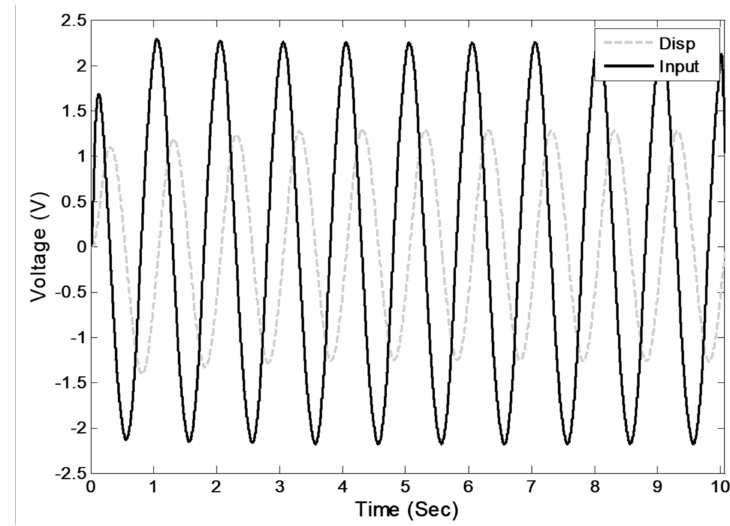
Figure 15. Comparison of the input voltage and the corresponding sinusoidal output voltage of the plant.